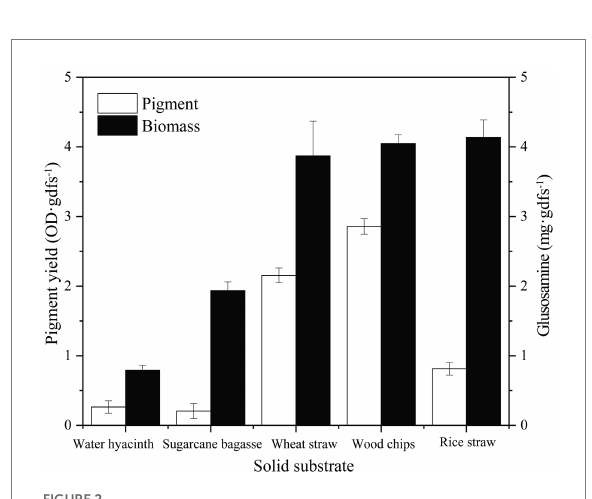
FIGURE 2 Effect of solid substrate on biomass and pigment production. Data correspond to the mean ± SD of three